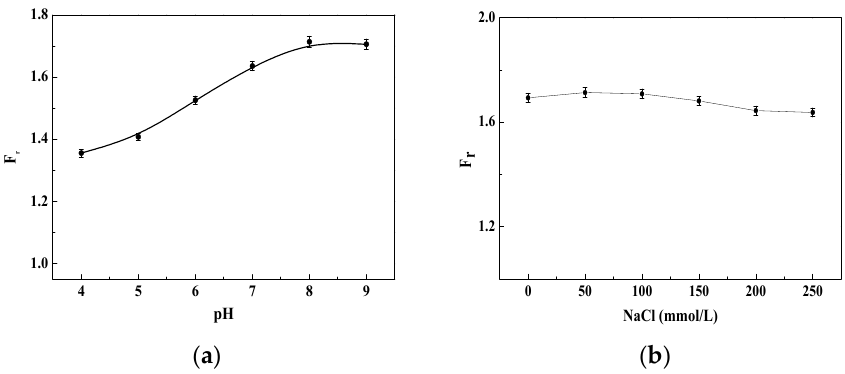
Figure 9. The fluorescence responses of the DNA detection system in different buffer conditions with 20 mmol/L Tris-HCl and 1.115 nmol/L ssDNA 10 . ( a ) pH; ( b ) NaCl concentration.